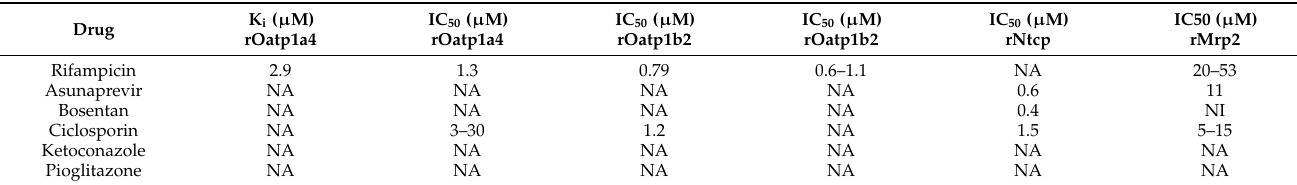
Table 2. In vitro inhibition constants (K i [ µ M]) and half maximal inhibitory concentrations (IC 50 [ µ M]) for selected drugs, against a range of rat hepatic uptake and biliary efflux transporters. Data were extracted from published literature [35–42].